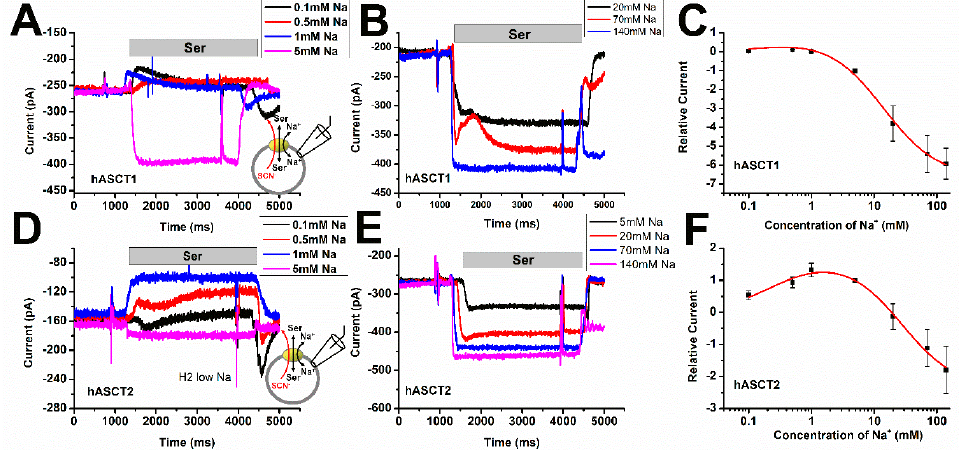
Figure 4. ASCT1 has slightly higher apparent affinity for Na + association to the serine-bound transporter than ASCT2. Whole-cell current recordings were performed to test the apparent affinity for Na + of ASCT transporters. ( A , D ) Typical serine-induced ASCT1 and 2 anion currents, measured under homo-exchange conditions at varying low [Na + ] (0–5 mM). Serine concentration was saturating (10 mM) extracellularly, with 130 mM NaSCN and 10 mM Ser inside the pipet. The duration of serine application is indicated by the gray bar. ( B , E ) Similar experiments as in ( A , C ), but in a [Na + ] range from 5 mM to 140 mM. ( C , F ) Serine induced maximum currents plotted as a function of [Na + ]. The K m for Na + was determined from fitting dose-response curves of a two Na + binding site function. I = I max1 * [Na + ]/( K Na1 + [Na + ]) + I max2 * [Na + ]/( K Na2 + [Na + ]). For ASCT2, K Na1 0.3 ± 0.1 mM, K Na2 is 27.9 ± 8.8 mM. For ASCT1, K Na1 is 0.3 ± 0.1 mM, K Na2 is 14.0 ± 3.4 mM. In all experiments, the transmembrane potential was 0 mV.